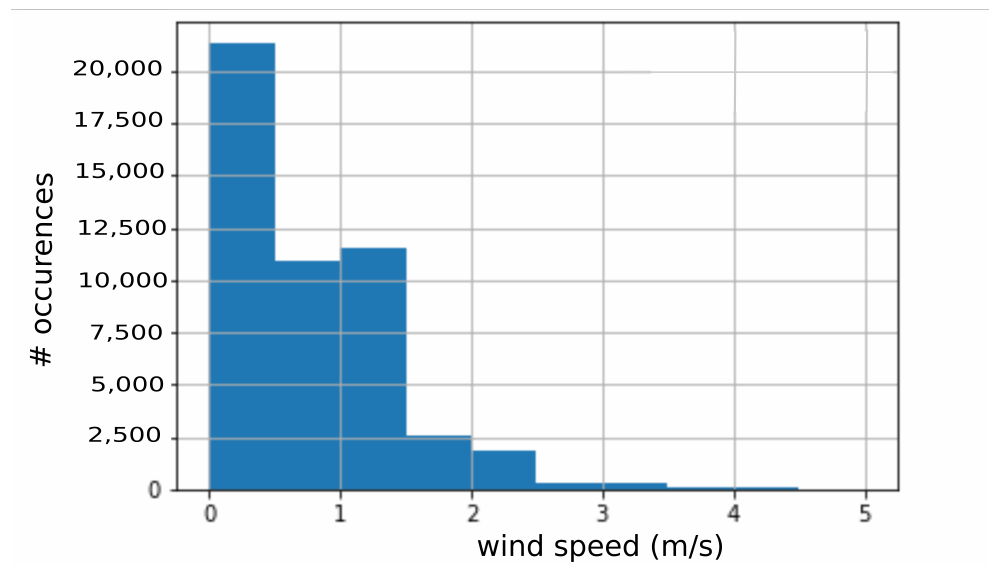
Figure 8. Nine days field testing